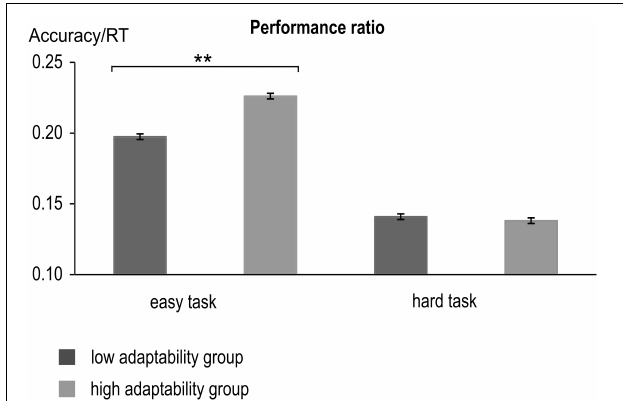
FIGURE 2 | Performance ratio (Accuracy divided by RT) of the low and high adaptability groups for the low and hard tasks. Error bars indicate standard errors ( ∗∗ p < 0.001). Both groups showed a larger performance ratio (i.e., better performance) in the easy task than in the hard task. In the easy task, performance ratio was furthermore larger for the high adaptability group than for the low adaptability